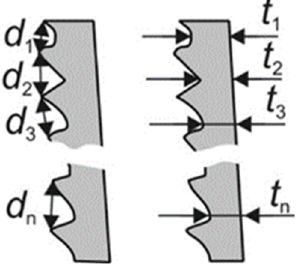
Figure 9. Chip shape criteria chip thickness t and lamella distance d .